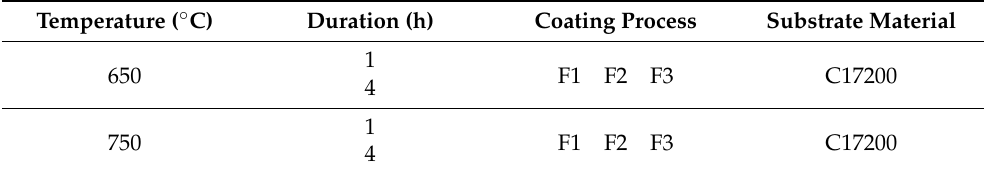
Table 5. The thermal diffusion parameters for the Cu-Ti films on the C17200 Cu alloys. Temperature ( ◦